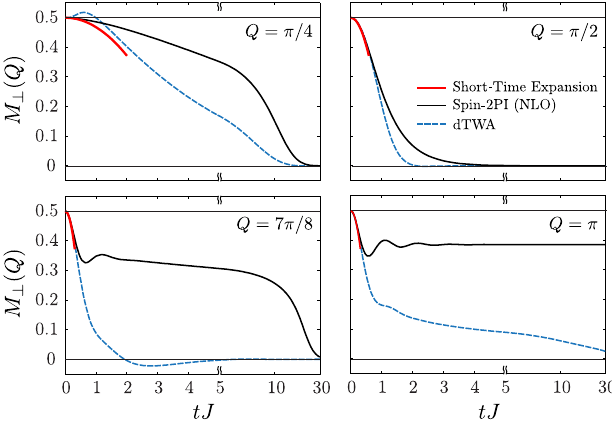
FIG. 6. Comparison between spin-2PI and semiclassical dy- namics. The spin-2PI results (solid black lines) are compared to the semiclassical dynamics obtained from the dTWA (dashed blue lines). The short-time analytic result from Sec. III A is also shown for reference (thick red lines). The long-time dynamics of the two methods are significantly different. In particular, the dTWA is not capable of describing the long-lived prethermal plateaus in contrast to the spin-2PI formalism. The scale of the time axis is switched from linear to logarithmic at tJ ¼ 5 for better